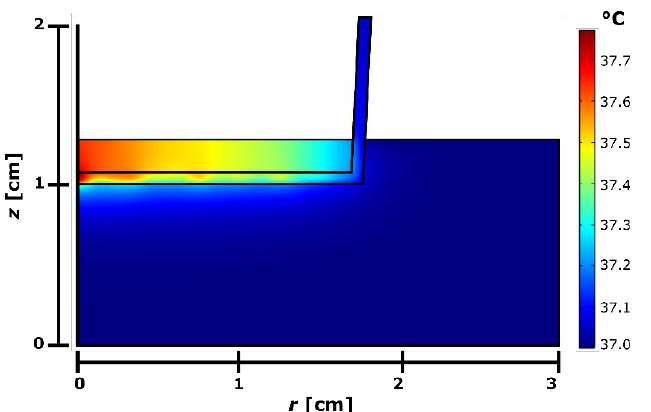
Figure 4. 2D axisymmetric modeled temperature for the experiments with ultrasound at 1.6 W/cm 2 at 50% DF after 5 min. A maximum temperature increment of 0.76 °C should not affect cell viability. This figure represents the result with the most intense experimental condition used in this work. Agitation produced by the acoustic force, not considered here, would also uniformize the heat in experiments, which would reduce the average temperature.